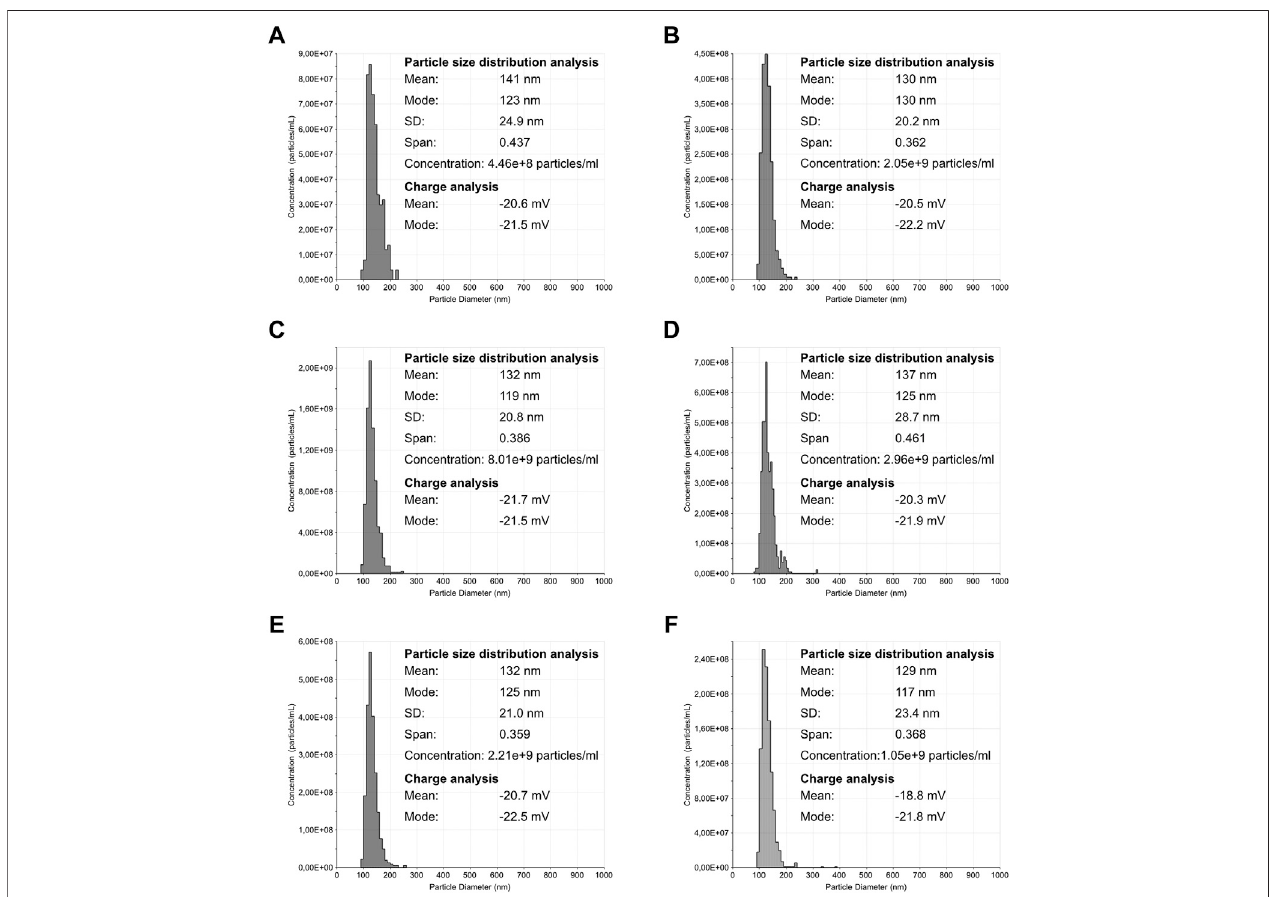
FIGURE 6 | Tunable resistive pulse sensing analysis of in fl uenza VLPs. Particle size distribution analysis of puri fi ed samples. The bin size for all histogram was de fi ned as 10 nm. (A) H1 Mono VLP, (B) H1 Penta VLP, (C) H3 Mono VLP, (D) H3 Penta VLP, (E) B Mono VLP, (F) B Penta VLP.